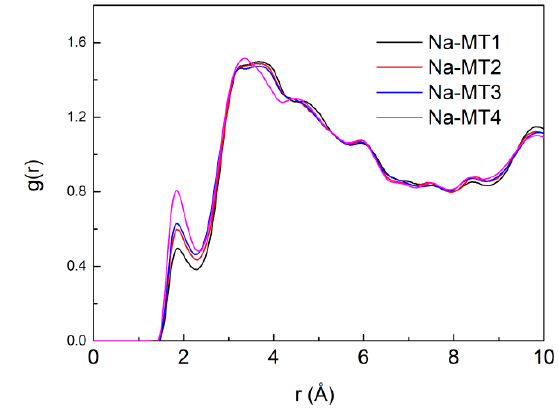
ff erent layer charge